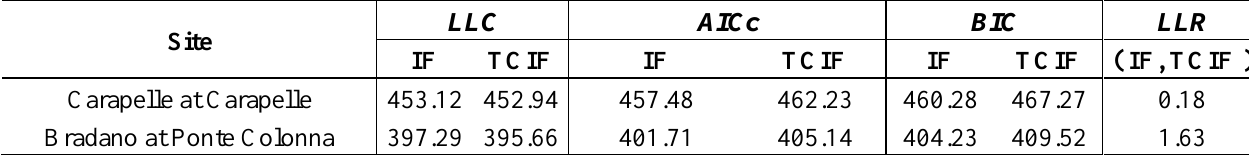
Table 3. Application of model selection